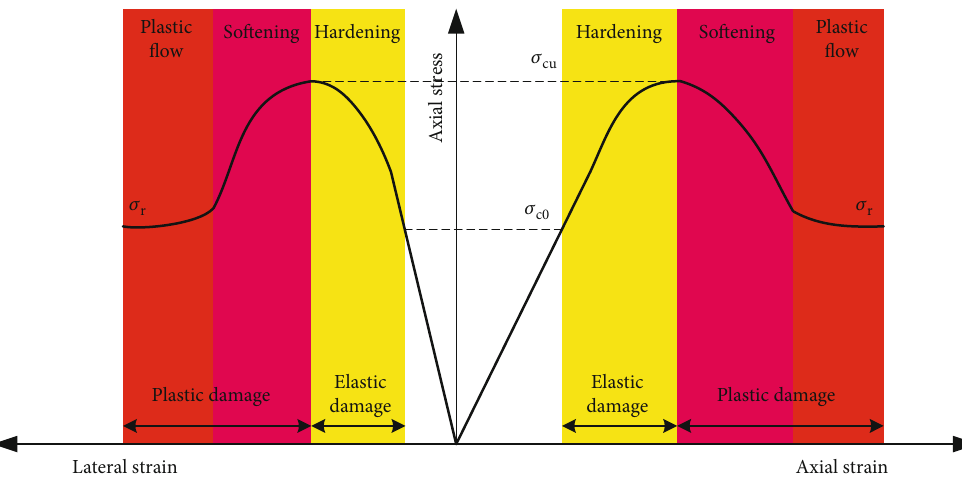
Figure 3: The stress-strain curve in di ff erent